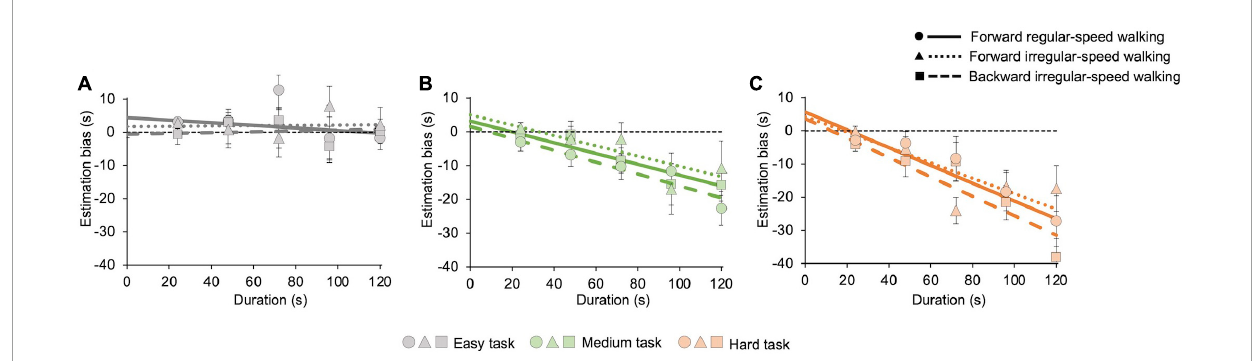
FIGURE4 Averaged estimation bias in different motor and cognitive tasks. Underestimation increases with cognitive load but does not change with the difficulty of the motor task. The graphs show the estimation bias, computed on 21 s intervals, for all cognitive and motor tasks with their best-fit curves. Error bars are SE across participants. Solid lines and dots represent the forward regular-speed walking condition; dotted lines and triangles represent the forward irregular-speed walking condition; dashed lines and squares represent the backward irregular-speed walking condition. Dashed black lines represent exact estimations. (A) Easy task (forward regular-speed walking: slope = –0.04 ± 0.04, intercept = 4.4 ± 2.2; forward irregular-speed walking: slope = 0.004 ± 0.05, intercept = 1.7 ± 3.1; backward irregular-speed walking: slope = 0.01 ± 0.03, intercept = –0.6 ± 1.6). (B) Medium task (forward regular-speed walking: slope = –0.2 ± 0.03, intercept = 3.1 ± 1.3; forward irregular-speed walking: slope = –0.15 ± 0.05, intercept = 4.9 ± 3.2; backward irregular-speed walking: slope = –0.2 ± 0.03, intercept = 1.6 ± 1.8). (C) Hard task (forward regular-speed walking: slope = –0.3 ± 0.08, intercept = 5.6 ± 4.2; forward irregular-speed walking: slope = –0.2 ± 0.04, intercept = 4.2 ± 2.8; backward irregular-speed walking: slope = –0.3 ± 0.06, intercept = 3.6 ± 3.1).